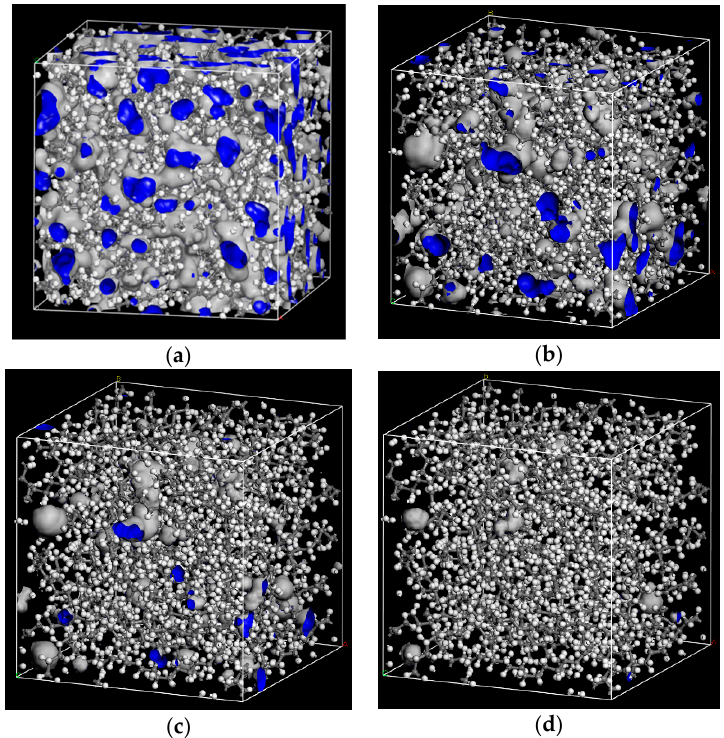
Figure 6. Free volume morphologies of the di ff erent probe radius in PE cell. ( a ) R P = 1 Å; ( b ) R P = 1.5 Å; ( c ) R P = 2 Å; ( d ) R P = 2.7